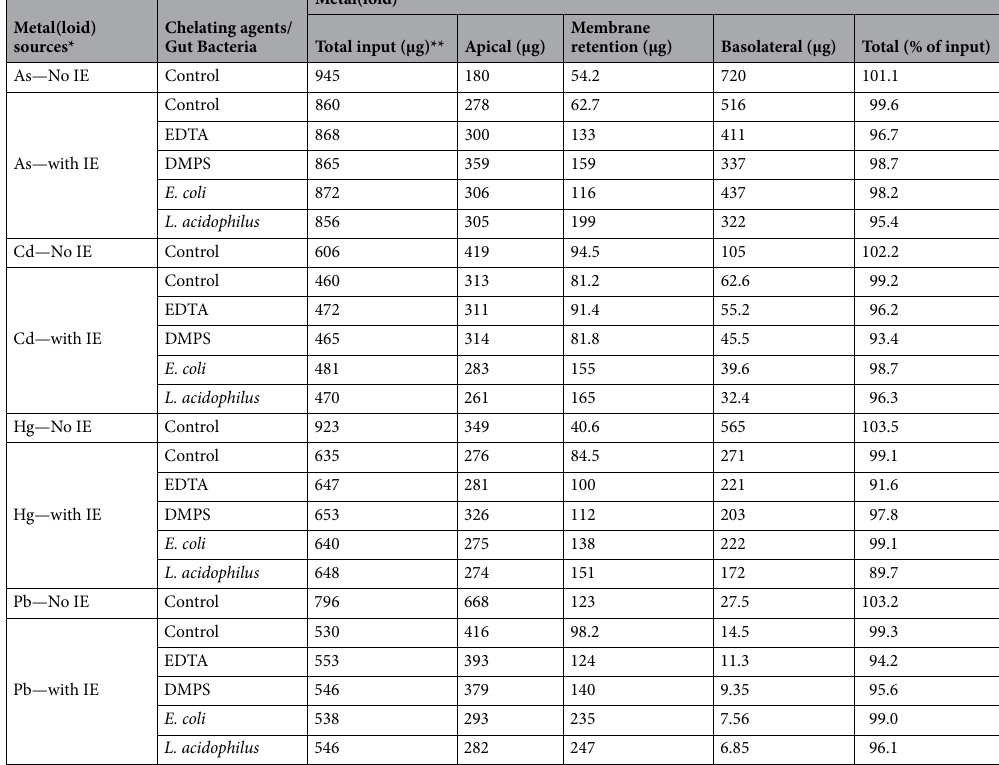
Table 1. Mass balance of metal(loid)s during permeability test using Caco-2 cell technique. *No IE, No Intestinal Extract; with IE, with Intestinal Extract. **Based on the measured concentrations in the test metal(loid) samples in the presence and absence of intestinal extract. Ethylene diamine tetraacetic acid (EDTA) and 2,3-dimercapto-1-propanesulfonic acid (DMPS); Escherichia coli and Lactobacillus